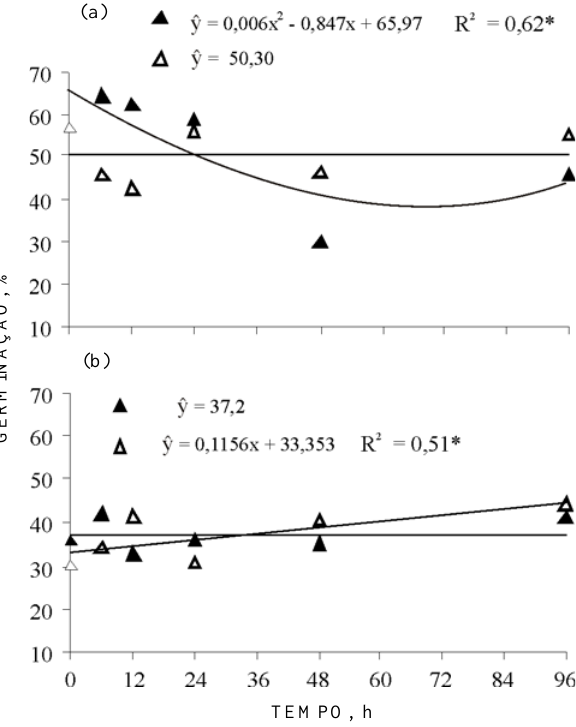
Figura 3. Germinação de sementes de Brachiaria 2. Germinação de sementes de Brachiaria